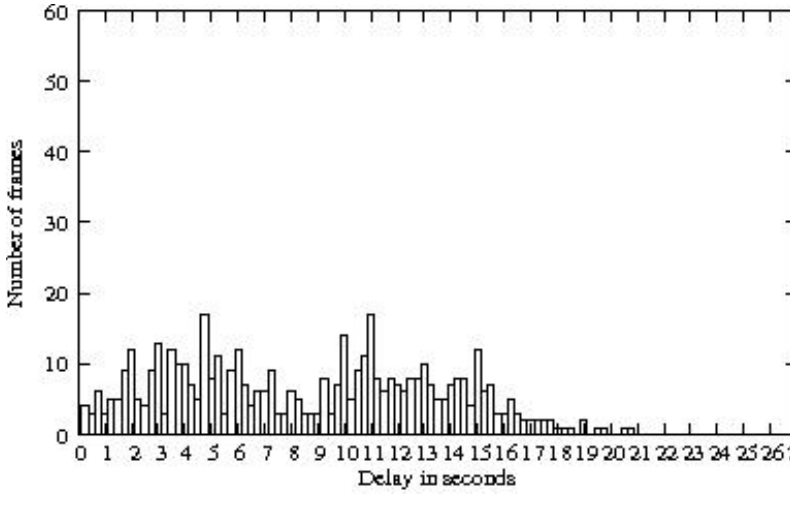
Figure 10. End-to-end delays for data-gathering traffic obtained with a general